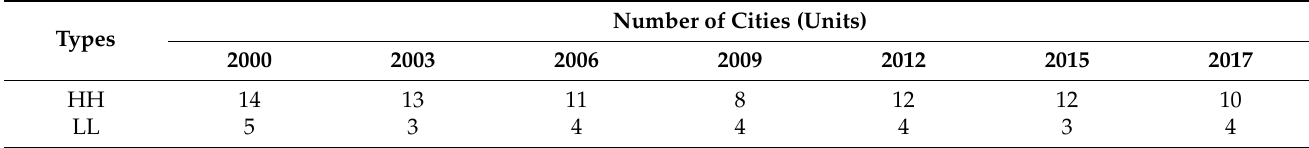
Table 3. Local spatial autocorrelation statistics of cities in study area.